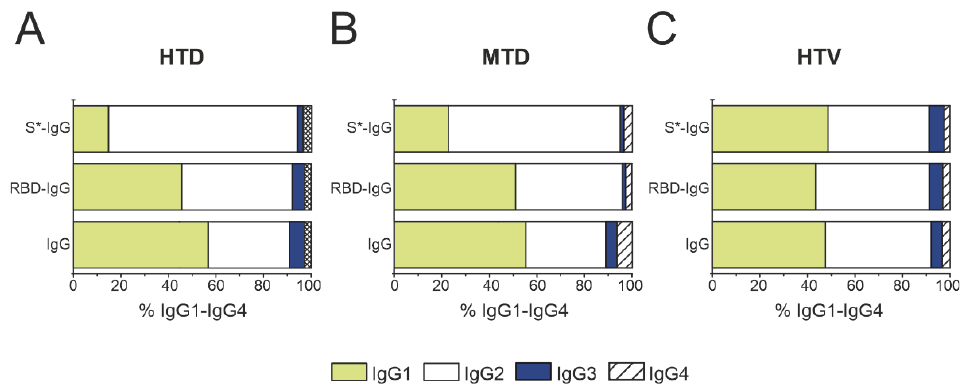
Figure 5. ELISA analysis of IgG subclasses in S*-IgG, RBD-IgG, and IgG preparations with no affinity for RBD- and S-Sepharose in three patient groups: HTD ( A ), MTD ( B ), and HTV ( C ). The measurement error did not exceed 5%.